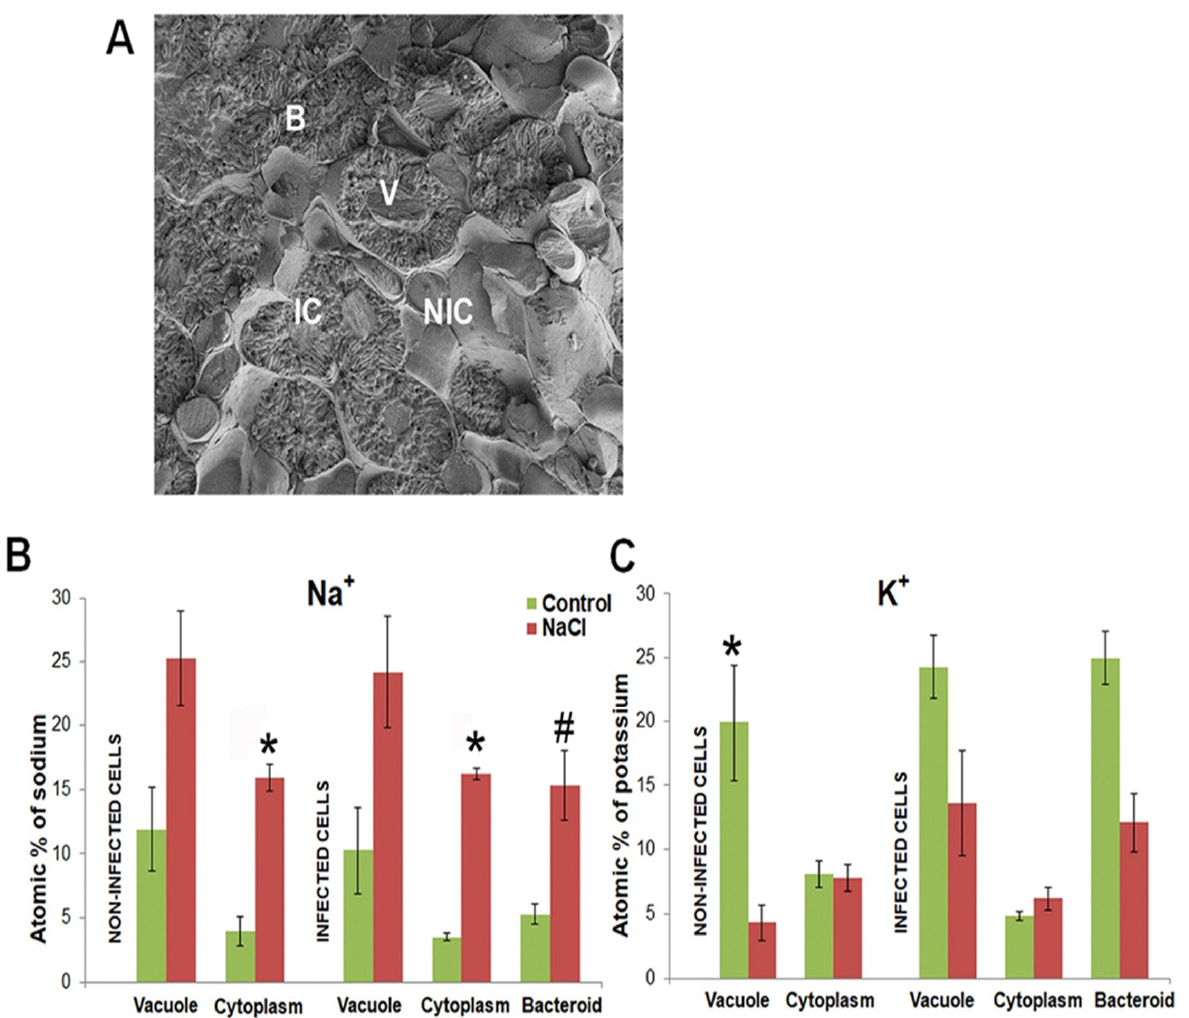
Figure 4. Scanning microscopy image of root nodule cells ( A ) and distribution of Na + ( B ) and K + ( C ) in cells of the nitrogen-fixing zone from control and salt-treated nodules of M. truncatula . B, bacteroid; IC, infected cell; NIC, non-infected cell; V, vacuole. (*) p -value ≤ 0.01, (#) p -value ≤ 0.05